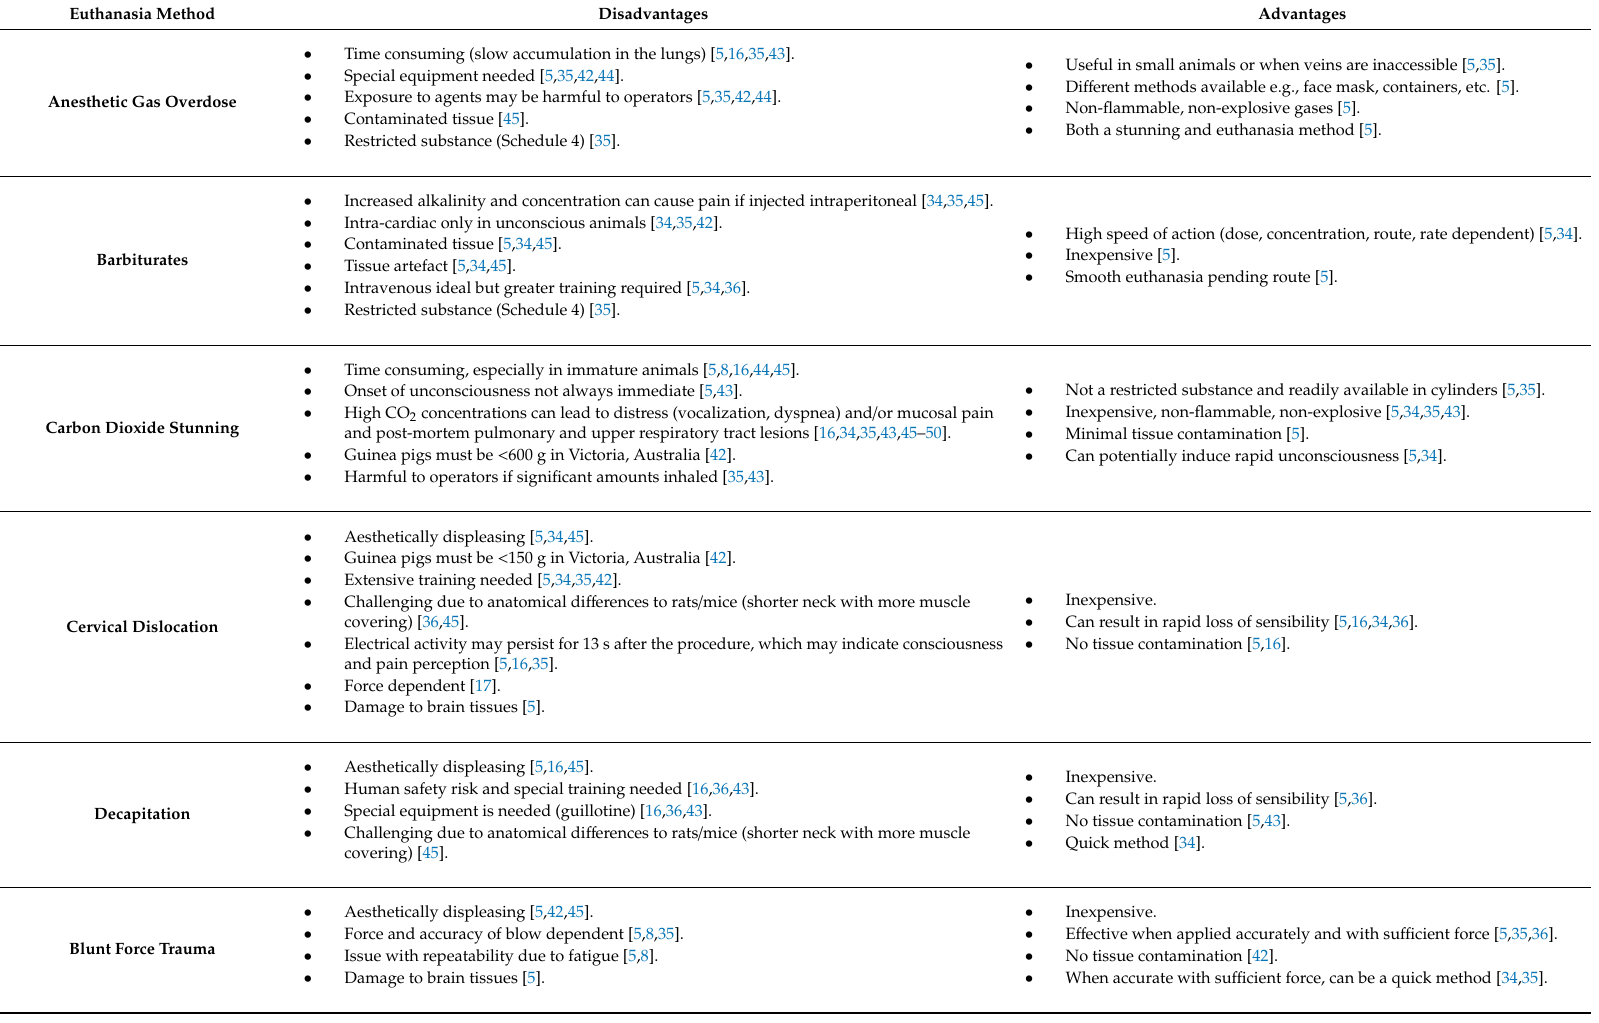
Table 1. Advantages and disadvantages of alternative euthanasia methods [5,16,34–36,42–44]. Euthanasia